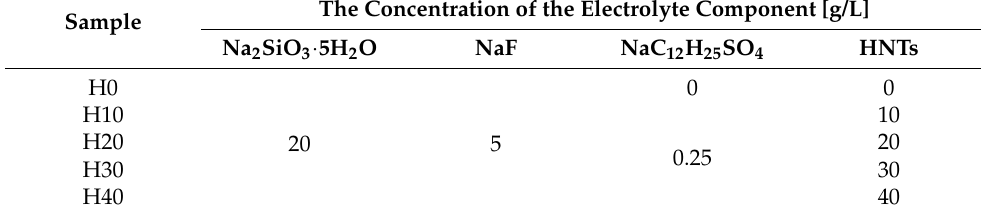
Table 9. Components of the used